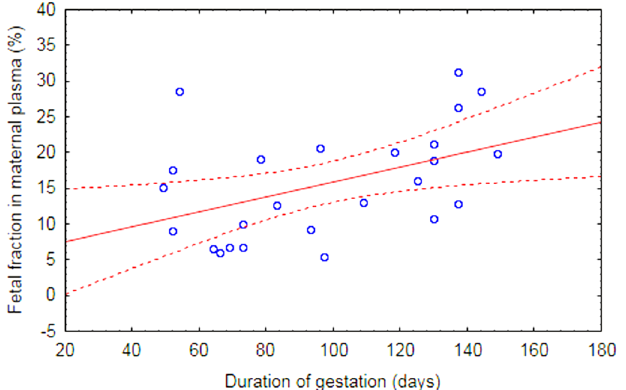
Fig 3. Correlation between gestational age and fetal cfDNA content in maternal circulation measured by ddPCR using RHD exon 10 /GAPDH ratio; r = 0.45936, p = 0.0208.